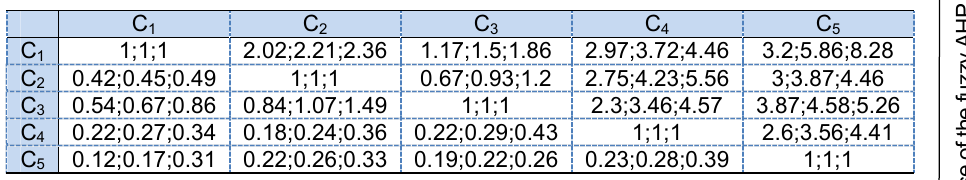
Table 5 – Comparison matrix in the pairs after the aggregation of experts’ matrices Таблица 5 – Матрица парного сравнения после агрегации матриц